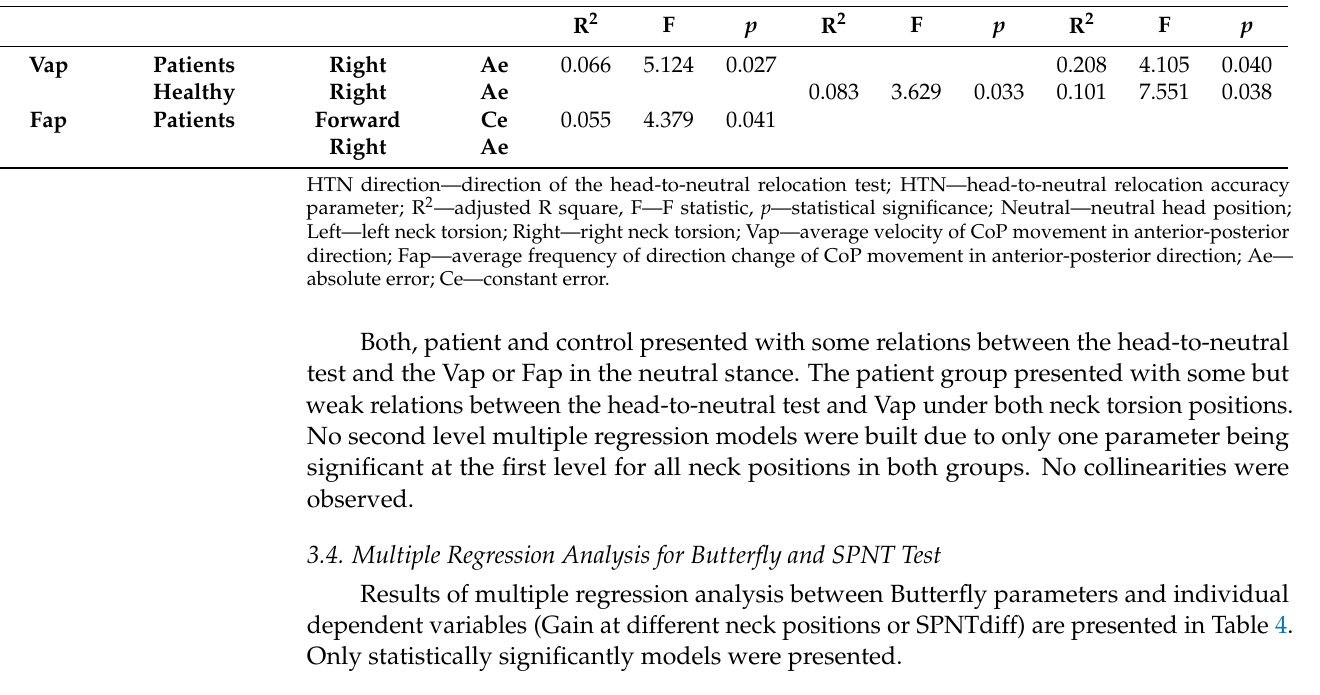
Table 4. Relations between eye movements during smooth pursuit neck torsion test and the butter- fly